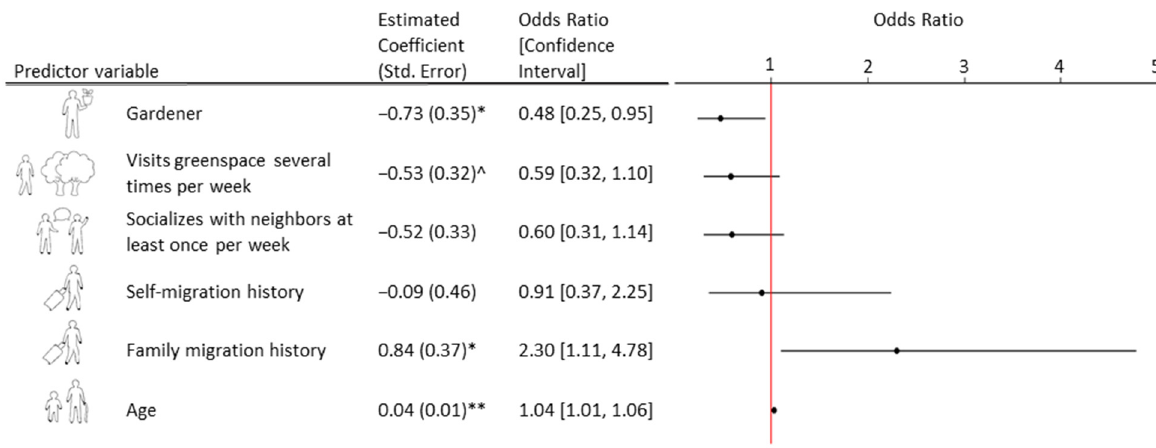
Figure 1. Estimated coefficients and their respective standard errors calculated from the multivariate logistic regression model with ‘at risk of depression’ as the response ( n = 282). The odds ratios and their confidence intervals calculated from these estimated coefficients are also provided and visually represented with an odds plot on the right. Two nature exposure variables, ‘gardener’ (baseline: ‘non-gardener’) and ‘visits greenspace several times per week’ (baseline: ‘visits greenspace once per week or less’), are reported. The other predictor variables included in the model are ‘socializes with neighbors at least once per week’ (baseline: ‘socializes with neighbors less than per week’), ‘self-’ and ‘family migration history’ (baseline: ‘no migration history’) and ‘age.’ Marginally significant results ( p < 0.1) are denoted with (ˆ), significant results ( p < 0.05) with (*) and highly significant results ( p < 0.01) with (**).